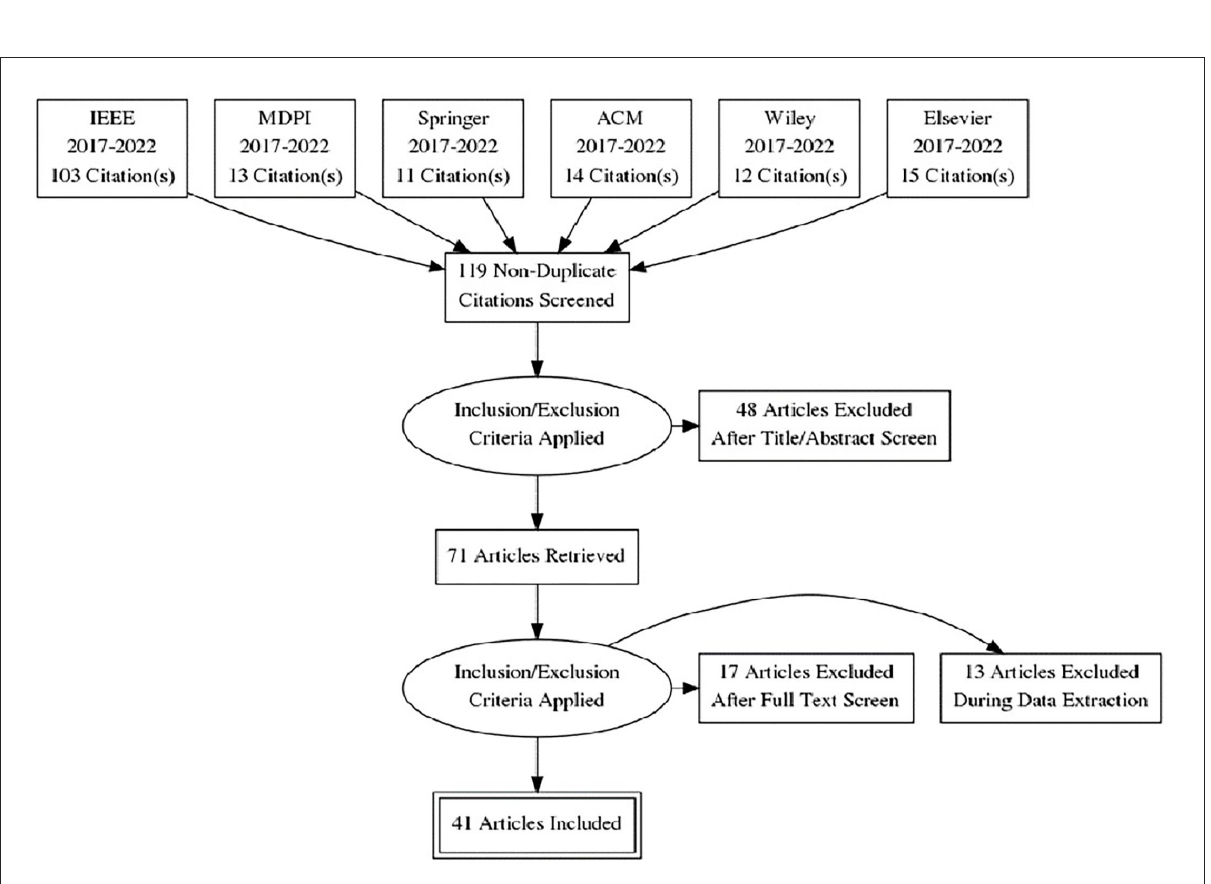
FIGURE1 PRISMA diagram of selection